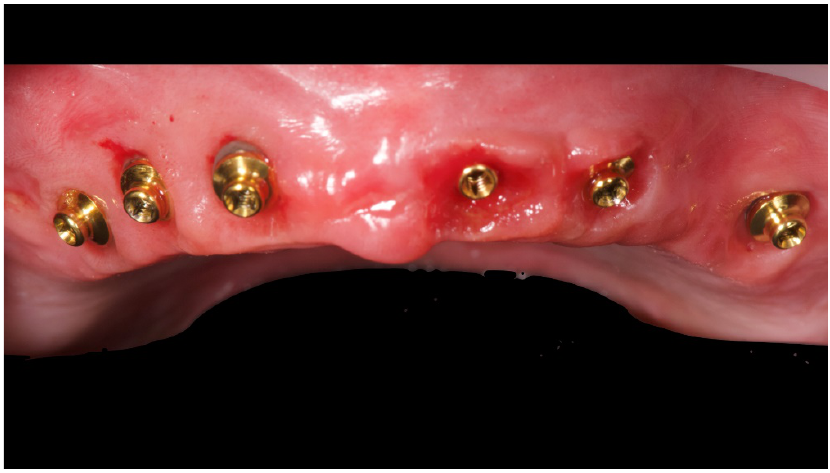
Figure 6. OT Equator used as abutment for the fixed prosthesis according to the OT Bridge system.